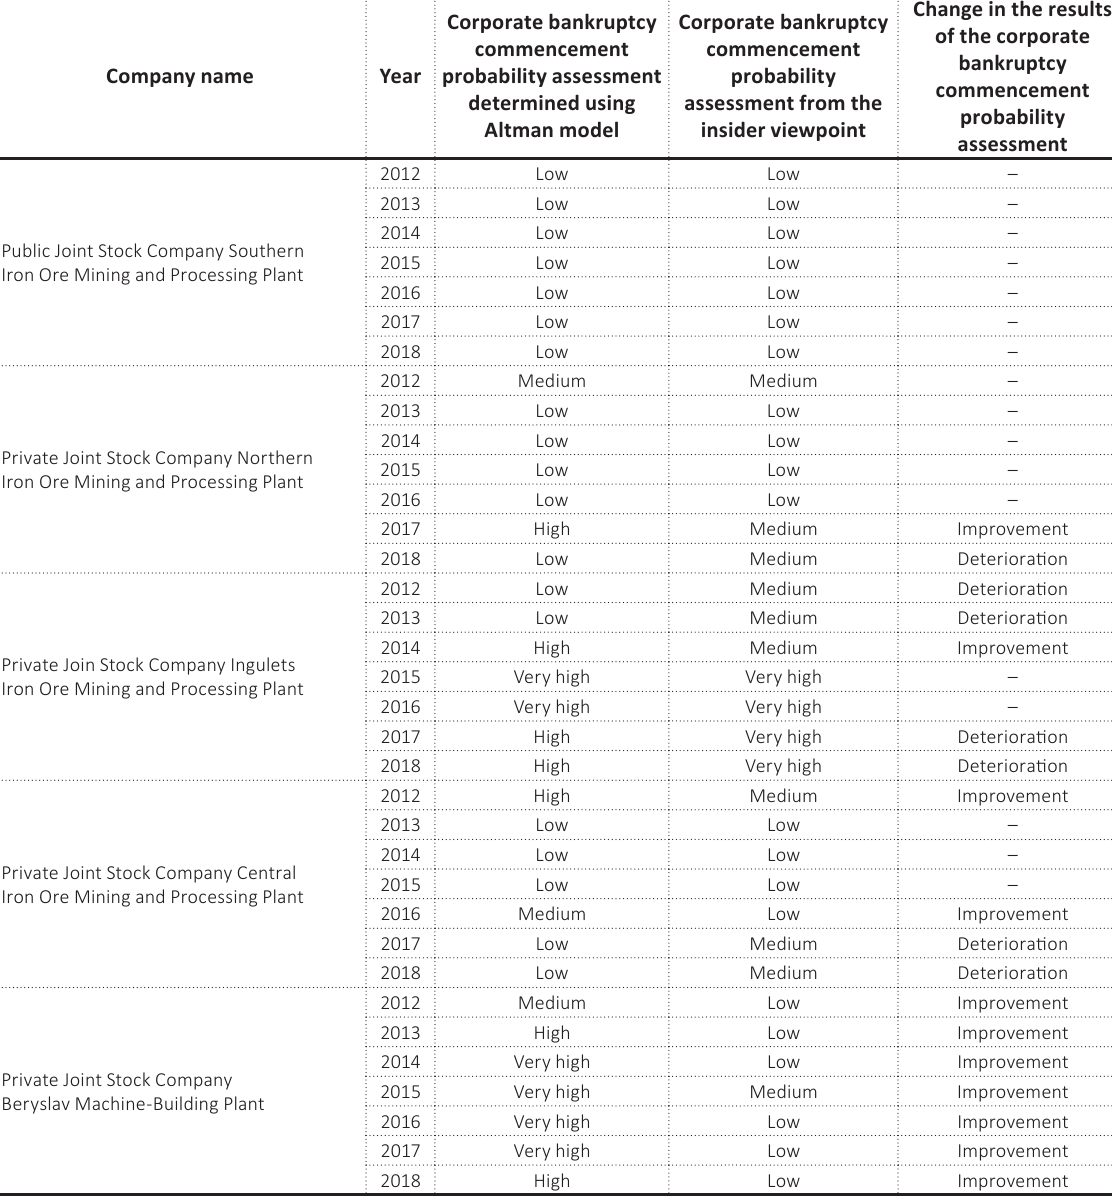
Table 6. Summary of the data regarding the bankruptcy commencement probability assessment conducted for the companies under research by external and internal users